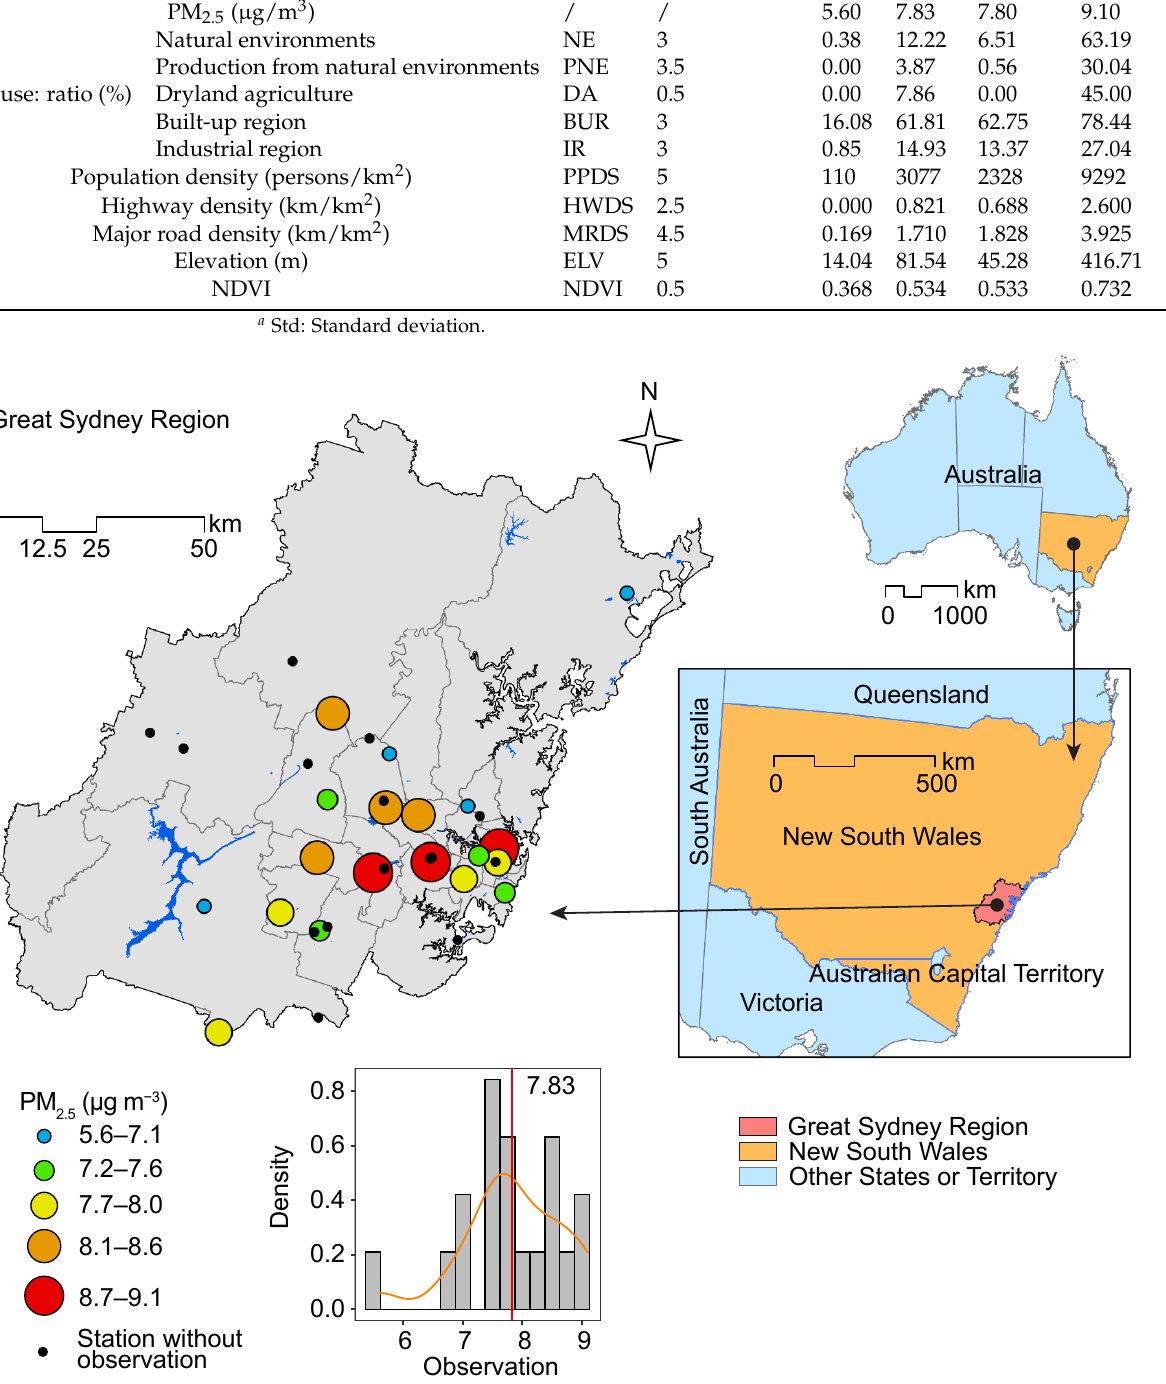
Figure 1. Spatial distributions of air quality monitoring stations and annual mean PM 2.5 in Great Sydney Region, New South Wales,